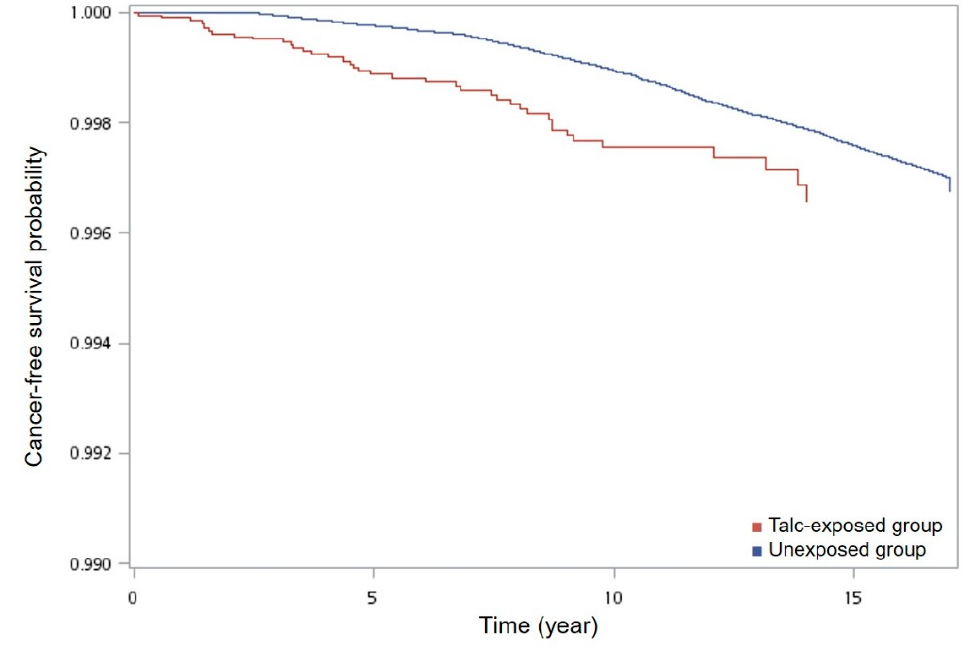
Figure 3. Cancer-free survival curve of patients with and without talc ingestion. Bottom half of figure is meaningless.